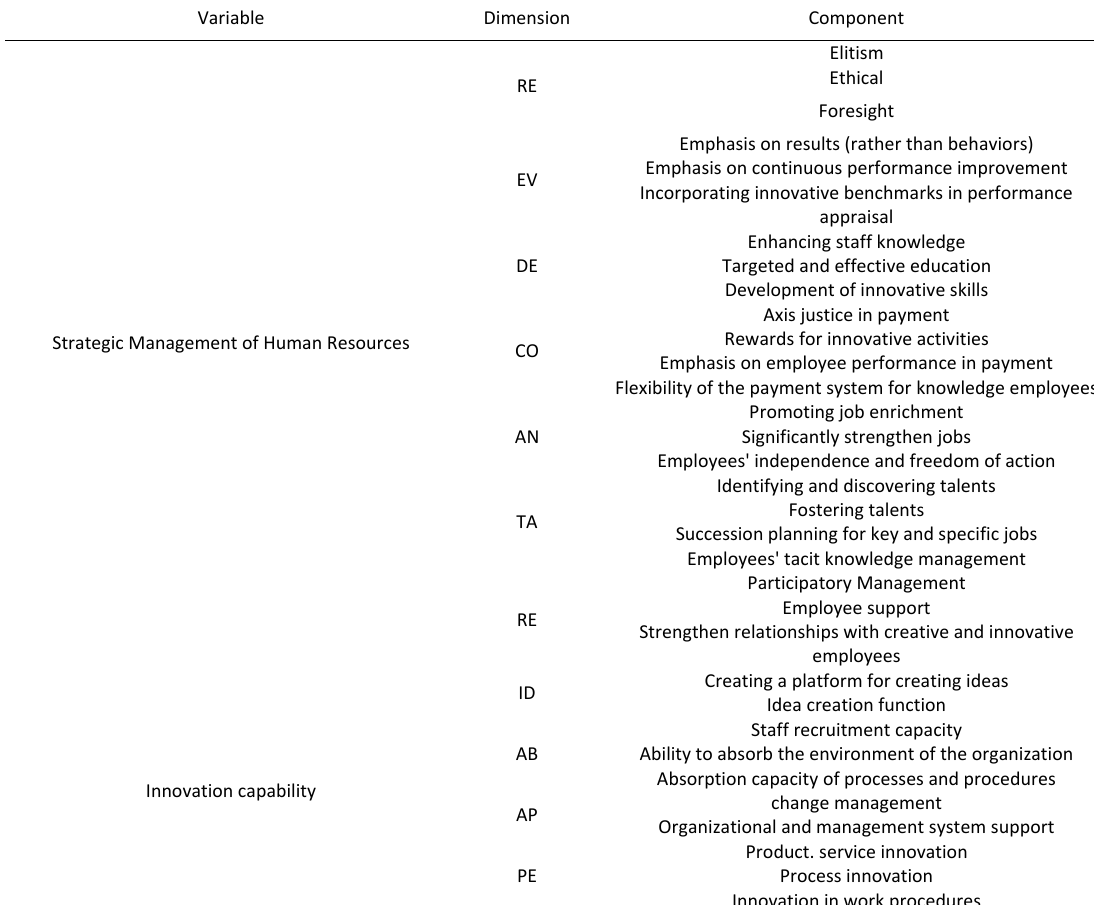
Table 2: Strategies of strategic HRM subsystems and dimensions and components of innovation capacity